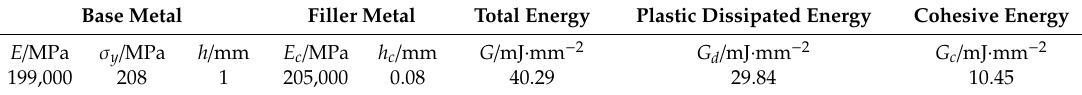
Table 5. Results of the tensile testing of T-type SS304/BNi-2 brazed joints.